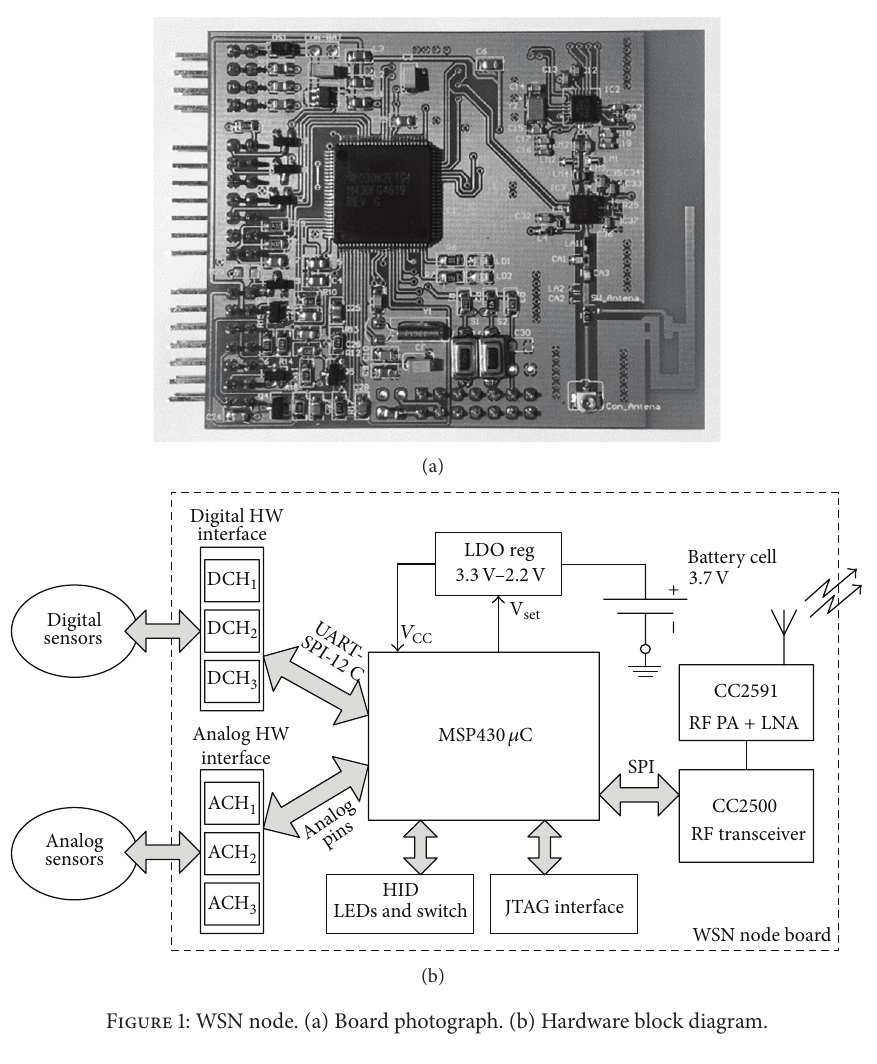
Figure 1: WSN node. (a) Board photograph. (b) Hardware block diagram.